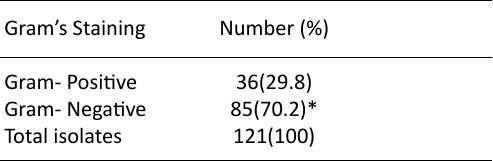
Table 2. Gram-staining of microbial isolates from urine samples in adult diabetic patients Gram’s Staining